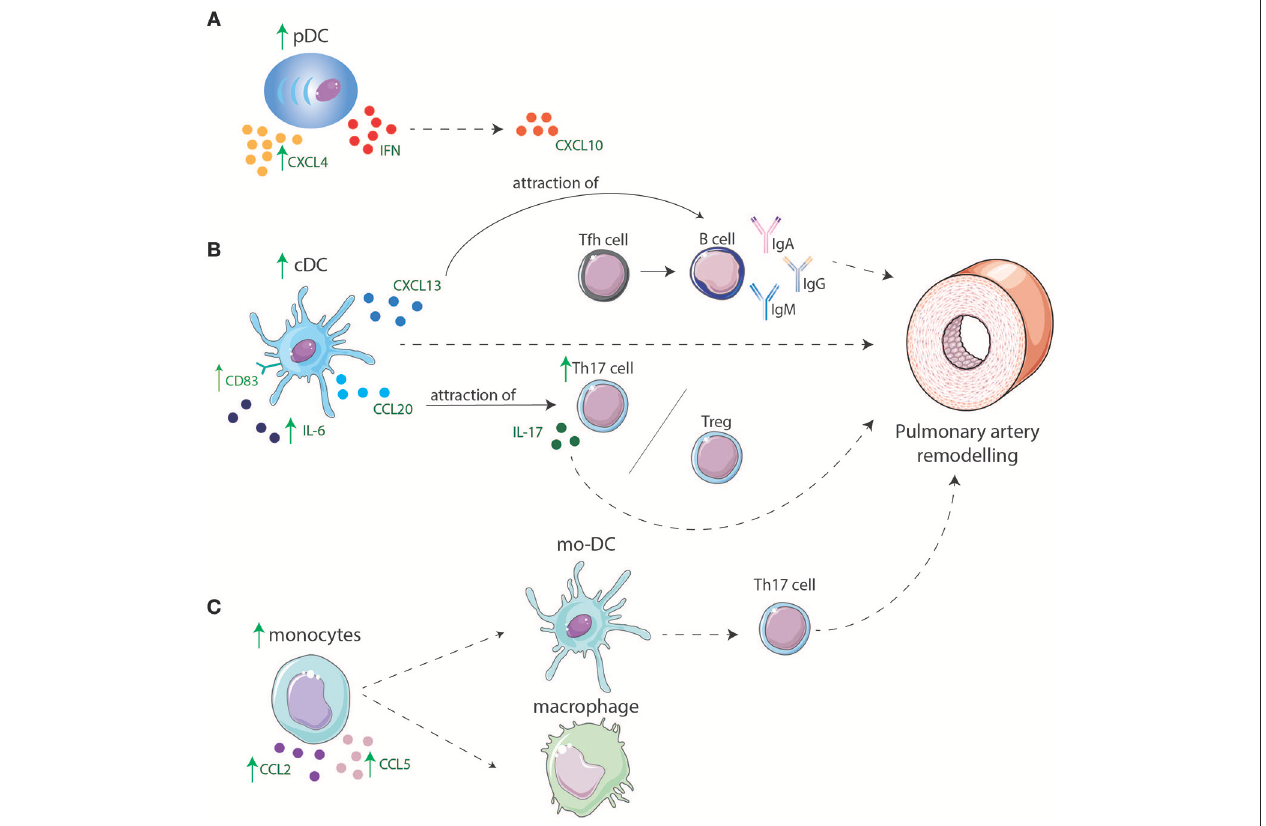
FIGURE 2 | Involvement of DCs and monocyte in lungs of IPAH and CTD-PAH patients. (A) pDCs are increased in lungs and might play a role in IPAH and CTD-PAH pathology by producing higher levels of CXCL4 and CXCL10 that is induced by IFNs. (B) cDC display higher levels of CD83 and have an enhanced cytokine production e.g., IL-6. cDCs are increased in lungs of PAH patients and can directly lead to PA remodeling or indirectly by production of CXCL13 and CCL20. CXCL13 leads to migration of B-cells toward the lungs, B-cells will produce pathogenic antibodies after interaction with Tfh cells, leading to remodeling of PAs. CCL20 attracts T-cells such as Tregs and Th17 cells leading to an increase in Th17 cells in the lung resulting in a Th17/Treg disbalance and by IL-17 production contributes to PA remodeling. (C) Monocytes are increased in the lung and produce CCL2 and CCL5 which might lead to attraction of other monocytes. Monocytes might differentiate in macrophages or mo-DCs. Mo-DCs induce Th17 cells adding to PA